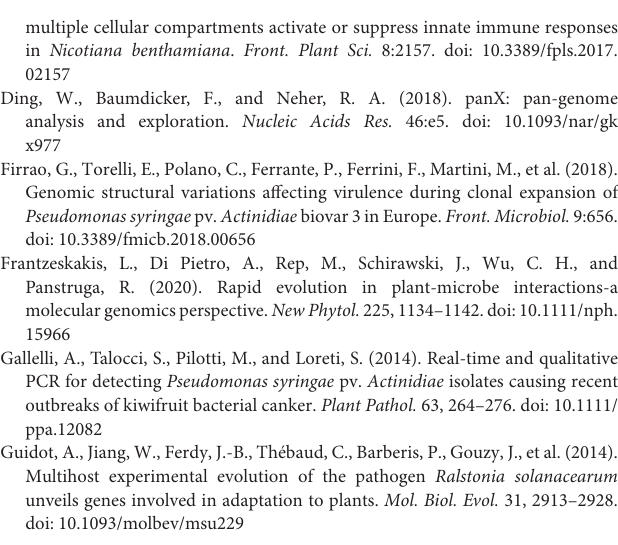
Supplementary Figure 1 | Hierarchical cluster analysis of pathogenicity data with the Ward’s method in SPSS 19.0. Supplementary Table 1 | Primers used in this study. Supplementary Table 2 | The detailed information of Psa3 isolates and MLVA typing results. Supplementary Table 3 | Results of the DNA pull-down